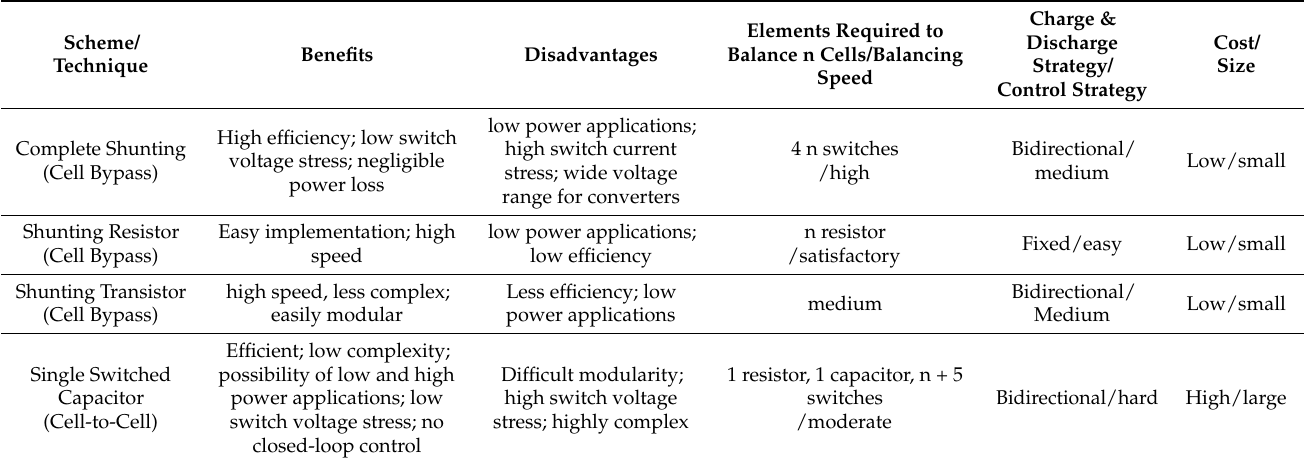
Table 9. Comparison of active cell balancing techniques. Adapted from [7,8,12,18,62,63]. Scheme/